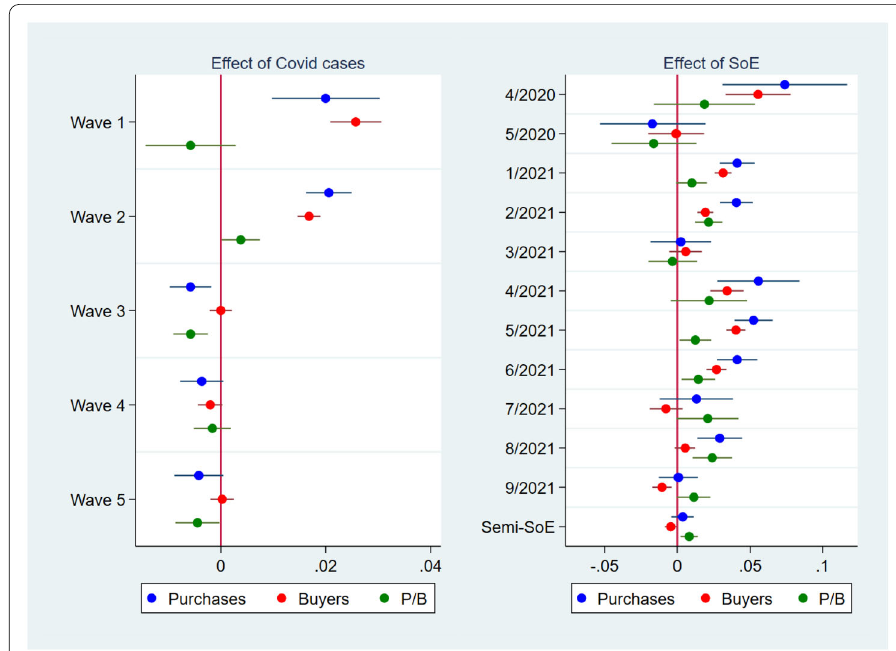
Figure 5 Effects of the Number of COVID-19 Cases and the Declaration of a State of Emergency on the Purchase Amount, the Number of Buyers, and the Purchase Amount per Buyer. This figure illustrates the results from the regressions of the purchase amount, the number of buyers, and the purchase amount per buyer in logs at the city-date level. The left panel shows the point estimates and 95% confidence intervals of the effect of the number of COVID-19 cases per 1000 persons averaged over one week on the purchase amount (blue), the number of buyers (red), and the purchase amount per buyer (green) in the five waves of COVID-19 in the sample period. The right panel shows the coefficients and 95% confidence intervals of the declaration of a state of emergency (SoE), separated into the months of the sample period and a semi-SoE, which is less restrictive than an SoE. The number of COVID-19 cases and the declaration of an SoE are given at the prefecture–date level. We take a log of the number of COVID-19 cases per 1000 persons plus 0.001 to incorporate possible nonlinear relationships. In all the regressions, the other independent variables are the number of neighboring prefectures in an SoE; the dummy variables for 1-4 weeks before and after the declaration of an SoE and a semi-SoE; and the city, date, and day-of-the-week fixed effects. The standard errors are clustered at the city level. N =